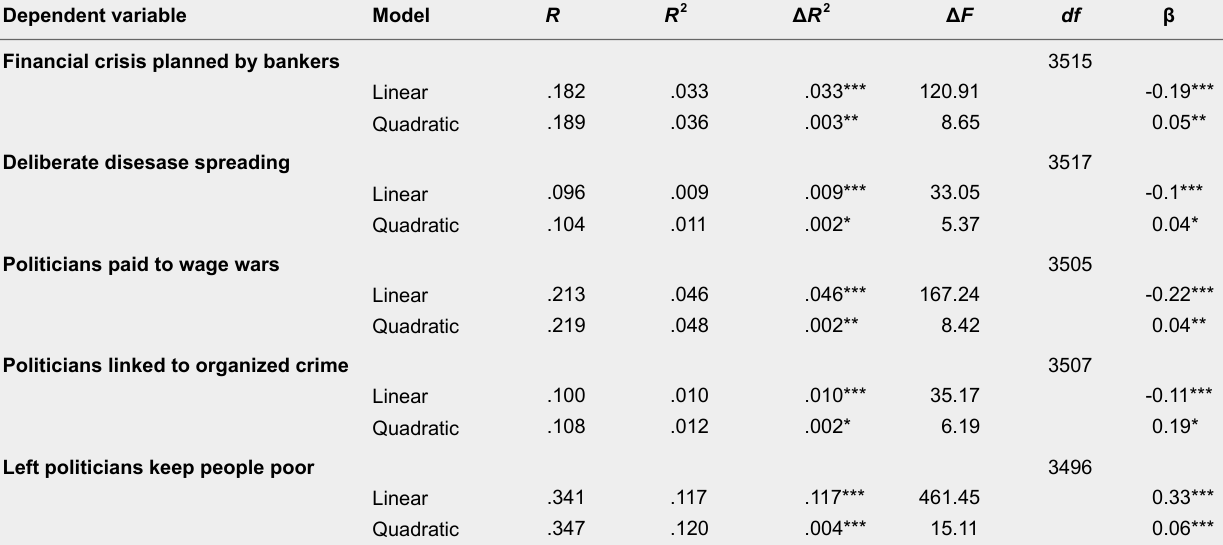
Political Ideology as Determinant of Conspiracy Theory